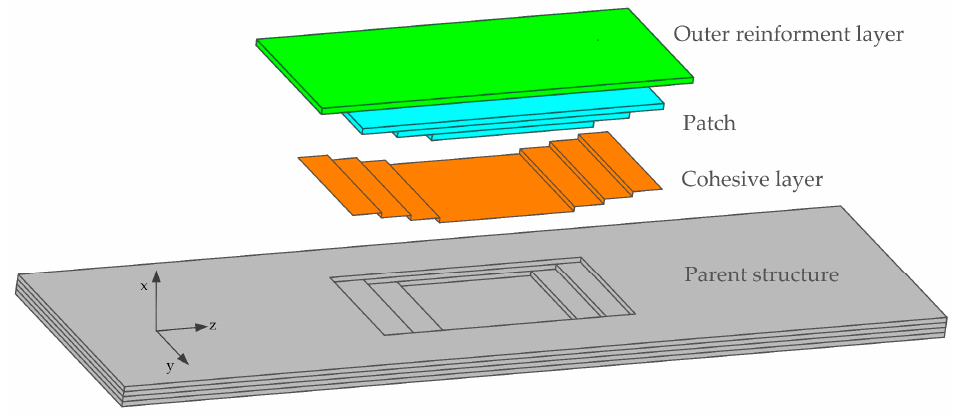
Figure 6. Structural analysis model.